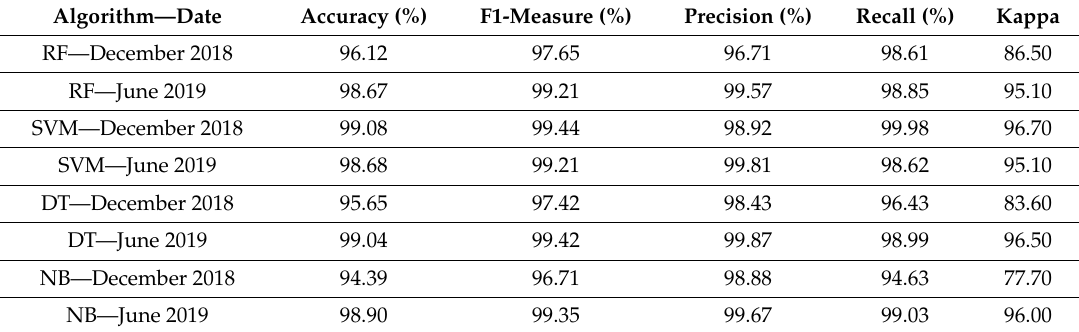
Table 5. Performance evaluation of four algorithms applying the trained model on di ff erent dates in the Paranapanema